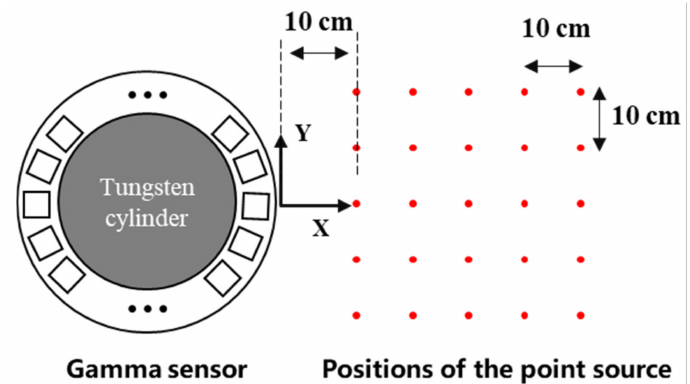
Figure 2. An illustration of the simulation-based experiment. The red points mark the position of the gamma source. The origin of the coordinate is set at a point located on the outer edge of the crystal